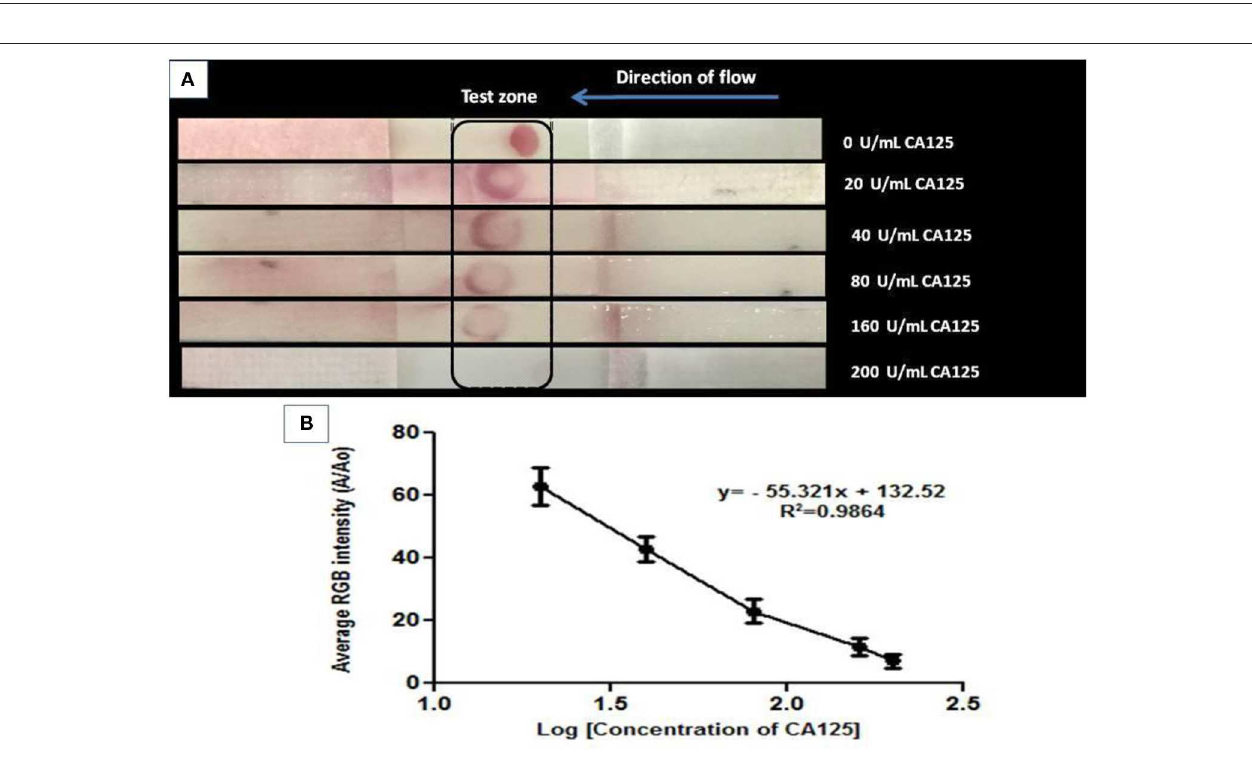
FIGURE 6 | (A) Visual detection of CA125 at its gradually increasing concentrations in competitive format through NALFA where 10 µ M aptamer was immobilized on NC laminate, and AuNPs- CA125 conjugate was applied on a reservoir matrix. The assay was run using varying concentrations (0–200 U/mL) of CA125 in 0.1M phosphate buffer as the test sample. (B) Quantification of NALFA using ImageJ software by calculating average RGB intensities.